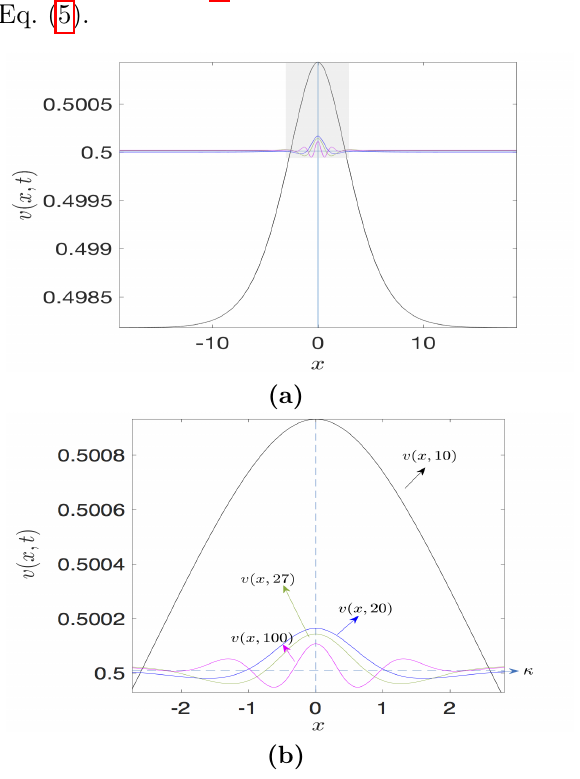
Figure 2. A bump solution u ( x, t ) at various times: t = 10(black), t = 20 (blue), t = 27 (green), t = 100 (ma- genta) is shown in (a). The region that is highlighted with gray in (a) is zoomed in (b). Parameters are κ = 0 . 5001, µ = 2 . 5, σ = 1 and the do- main size is L = 6 π . The initial condi- tion is chosen as u ( x, 0) = 2 / cosh( x